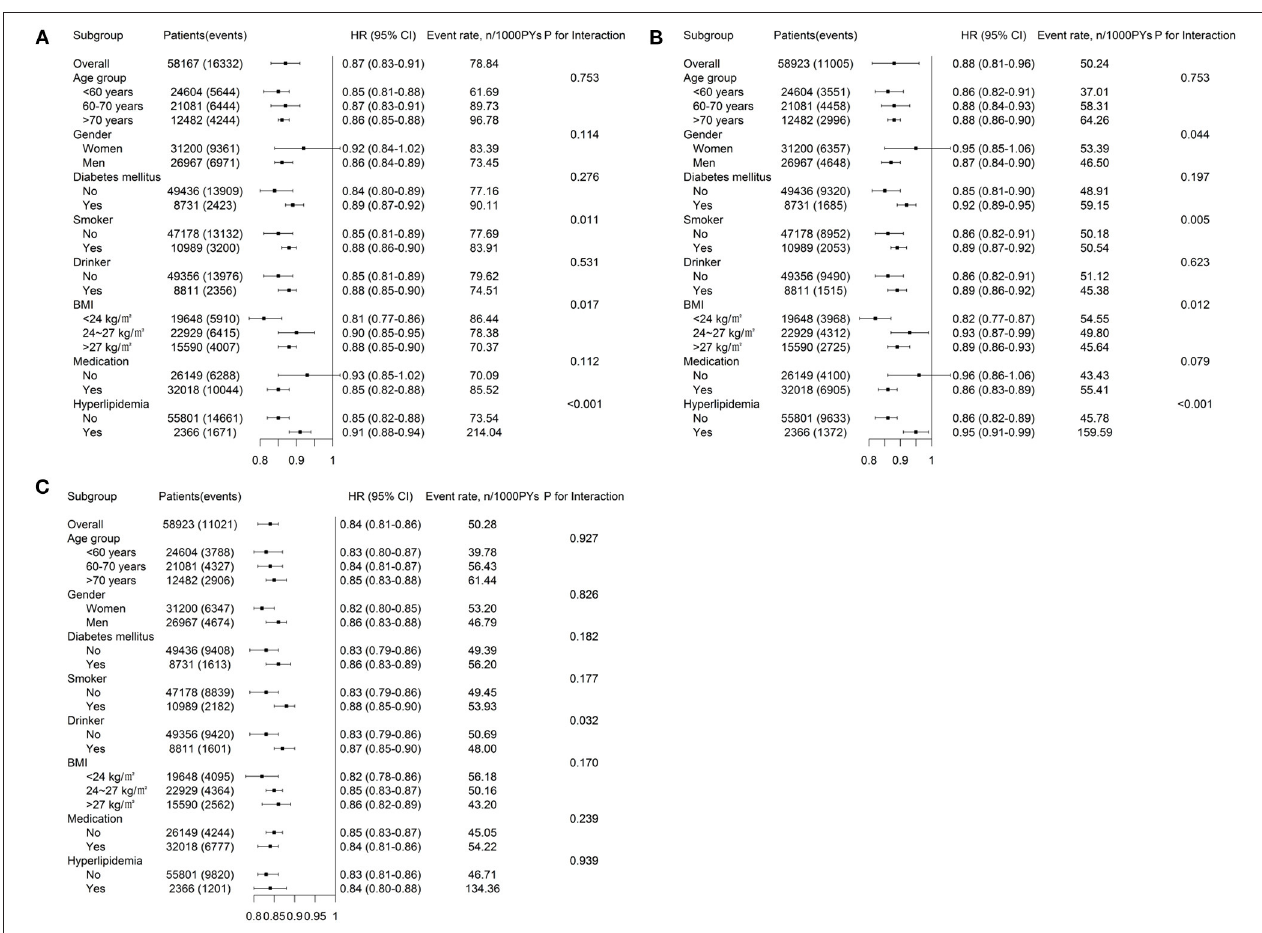
FIGURE 1 | Adjusted HRs (95% CIs) for (A) CVD, (B) CHD, and (C) CBD associated with time-updated LTPA estimated by the MSM. HRs, hazard ratios; CVD, cardiovascular disease; CHD, coronary heart diseases; CBD, cerebrovascular diseases; BMI, body mass index; LTPA, leisure time physical activity; PYs, person-years; P -value is for interactions of time-updated LTPA with these